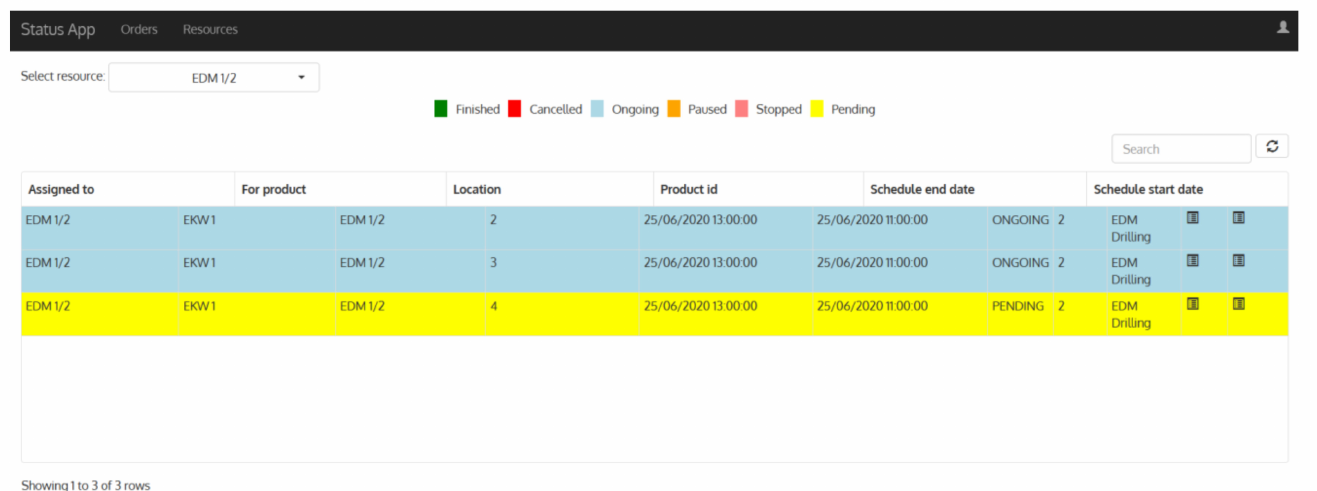
Figure 5. Shopfloor status app–Orders monitoring